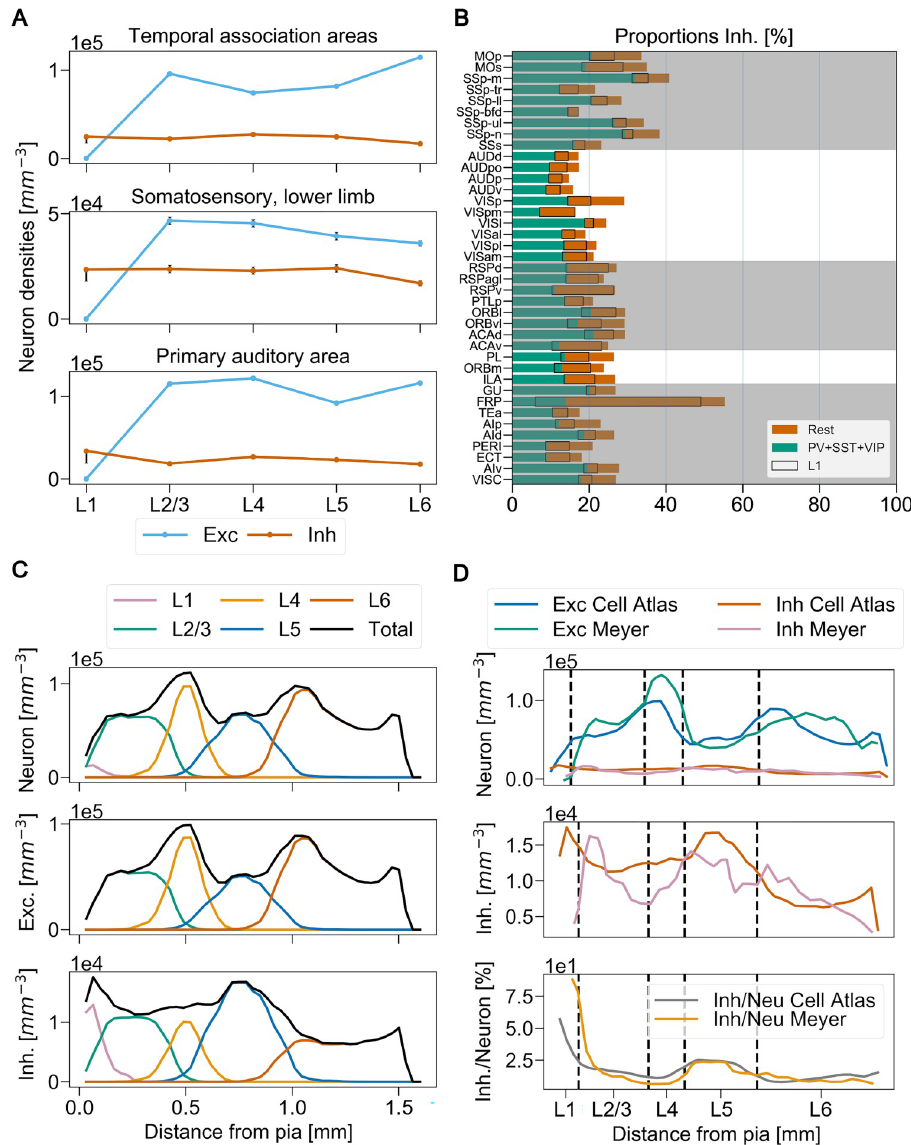
Fig 8. Cortical excitatory/inhibitory ratios. (A) Relative cortical layer cell densities from the primary somatosensory cortex lower limb (SSp-ll), primary auditory cortex (AUDp) and temporal association areas (TEa). Blue lines correspond to excitatory neuron densities (Exc) and the orange lines inhibitory neuron densities (Inh) in cells/mm 3 . Final confidence intervals are also displayed for each layer as vertical lines. (B) Ratios of inhibitory/excitatory neurons (Inh/Exc) across anatomical regions of the isocortex, expressed as percentage and arranged in five subnetworks based on Kim et al. [7]. Acronyms correspond to the AV naming convention [60] (see Table A in S1 Document). The portion of inhibitory neurons that belongs to L1 is shown with a black contour. (C) Somatosensory barrel field neuron distributions according to pia. Each layer is represented by a different color and the total density according to distance to pia appears in black. (D) Somatosensory barrel field excitatory/Inhibitory neuron distributions (Exc/Inh) according to pia compared to the results extracted from figures 2EFG from Meyer et al. [95]. AV mean layer limits are represented as dash lines and aligned to the ones provided by Meyer et